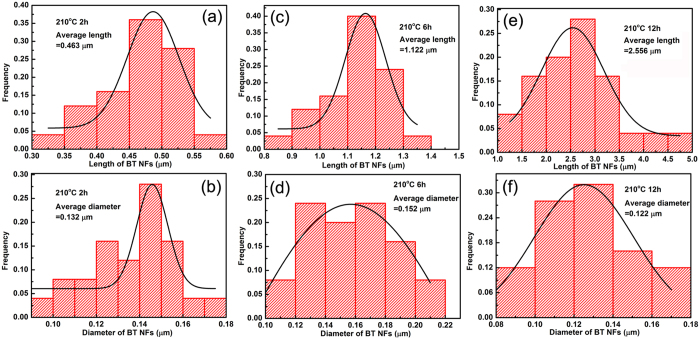
BaTiO3 NFs length and diameter distribution for different reaction times.(a,b) 210 °C. 2 h. (c,d) 210 °C. 6 h. (e,f) 210 °C, 12 h.